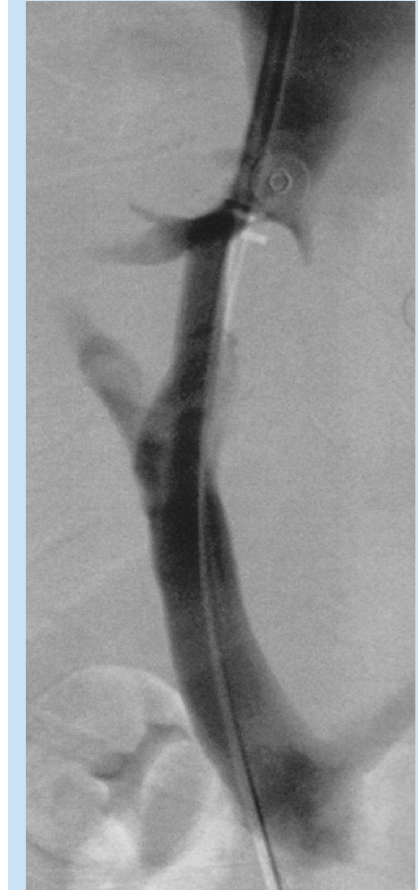
Fig. 1c. A final check portogram shows flow of contrast through the shunt into the hepatic vein thereby decompressing the portal system. It is important that there still be some visible flow of contrast beyond the stent into the intrahepatic por- tal branches otherwise encephalopathy and liver failure may